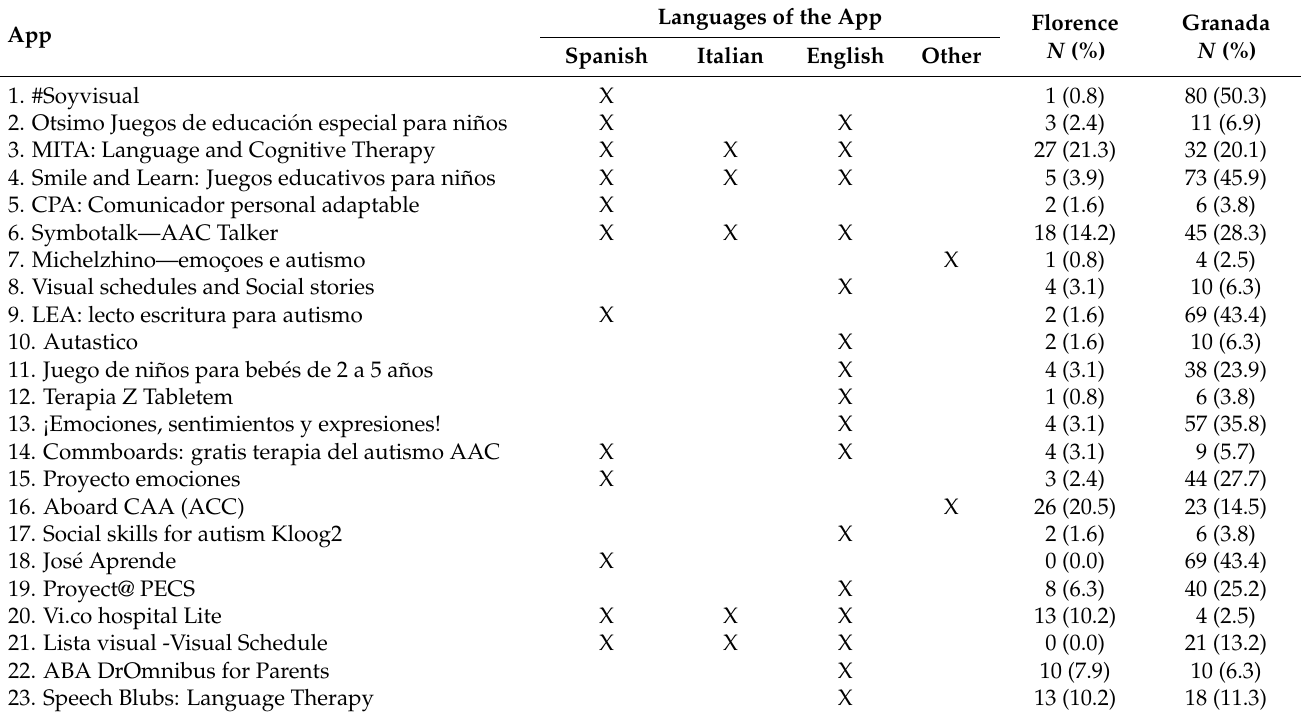
Table 15. Quality, specialized apps for people with autism used by the teachers from Florence and Granada. Languages of the App